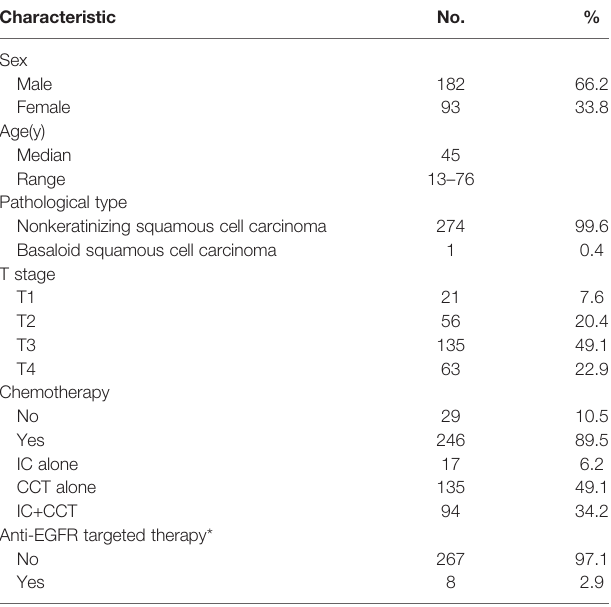
TABLE 2 | Failure patterns of treatment in the 275 patients with stage N1 nasopharyngeal carcinoma treated by contralateral lower neck sparing